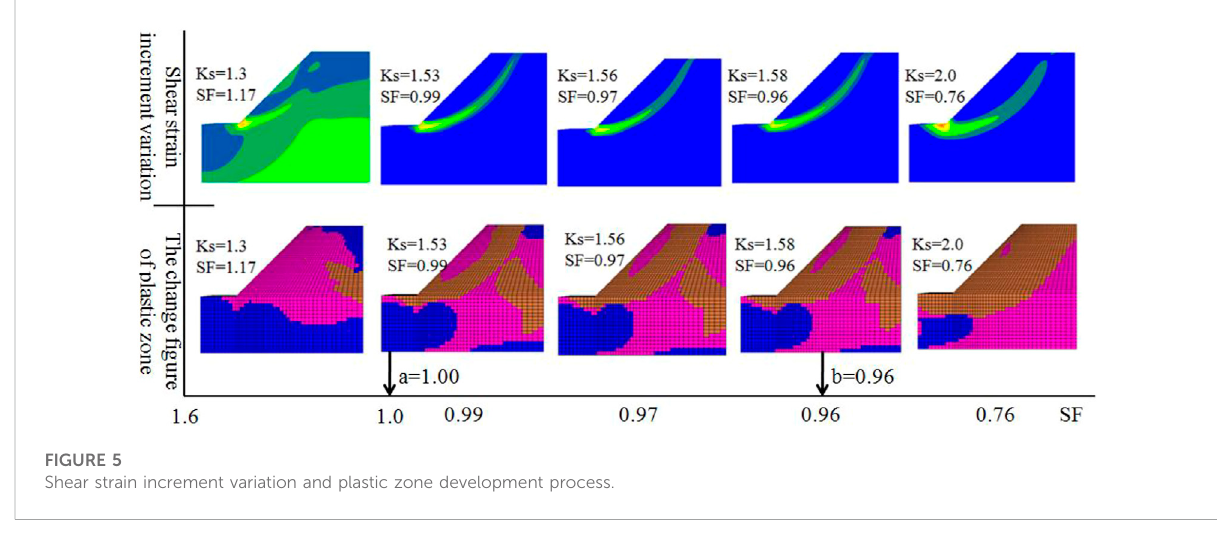
FIGURE 5 Shear strain increment variation and plastic zone development process.